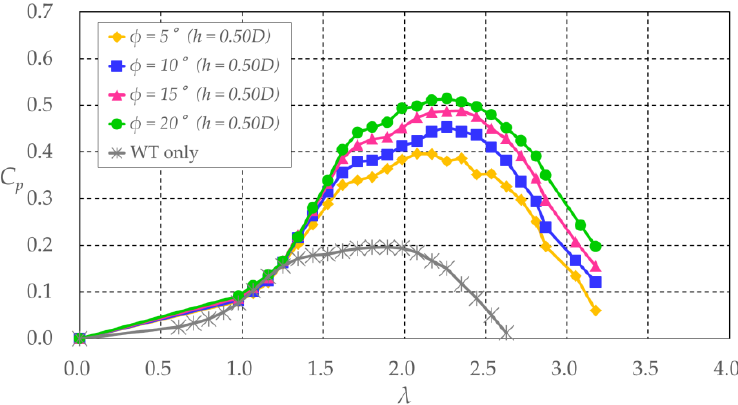
Figure 4. Power coefficient C p of wind turbines with and without a wind lens vs. tip speed ratio λ (diffuser length: L = 1.14 D m). Refer to Figure 2 for h , D , and L .